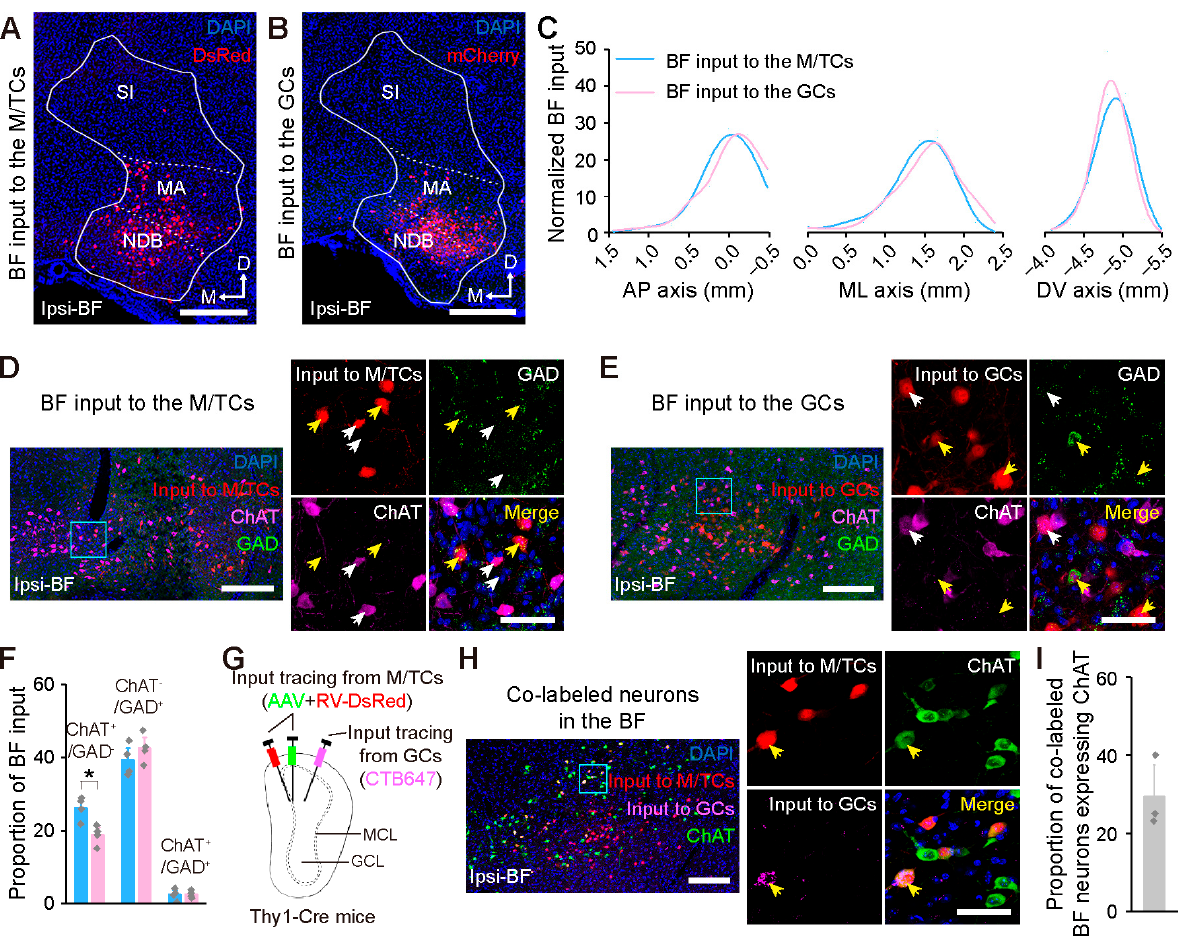
Figure 5. Organization of the centrifugal input from the BF to the OB. ( A , B ) Input neurons in the ipsilateral BF following retrograde tracing from the M/TCs ( A ) and GCs ( B ). NDB, diagonal band nucleus; MA, magnocellular preoptic nucleus; SI, substantia innominata. ( C ) Cumulative distribution of the input neurons in the BF along the AP, ML, and DV axes. ( D , E ) Left: Representative image showing ChAT-expressing and/or GAD65/67-expressing input neurons in the BF following retrograde tracing from the M/TCs ( D ) and GCs ( E ). Right: Magnification of the blue outlined area in the left-hand image. The white and yellow arrowheads indicate ChAT-expressing and GAD65/67-expressing input neurons, respectively. ChAT, choline acetyltransferase; GAD, glutamate decarboxylase. ( F ) Proportion of the BF input neurons expressing ChAT + /GAD − , ChAT − /GAD + , and ChAT + /GAD + . Unpaired two-tailed t -tests. * p < 0.05. n = 4 animals. ( G ) Strategy for dual-retrograde tracing from the M/TCs and GCs using two different colored retrograde tracers, namely the RV-based retrograde monosynaptic tracing viruses and the CTB647. ( H ) Left: Representative image of co-labeled neurons expressing ChAT in the BF. Right: Magnification of the blue outlined area in the left-hand image. The arrowhead indicates a ChAT-expressing co-labeled neuron. ( I ) Proportion of ChAT-expressing co-labeled neurons in the BF. n = 3 animals. Data are shown as the mean ± s.e.m.; gray rhombuses denote individual animals in ( F , I ). Scale bars, 500 µm in ( A , B ); 200 µm in ( D ) (left), ( E ) (left), and ( H ) (left); and 50 µm in ( D ) (right), ( E ) (right), and ( H ) (right).